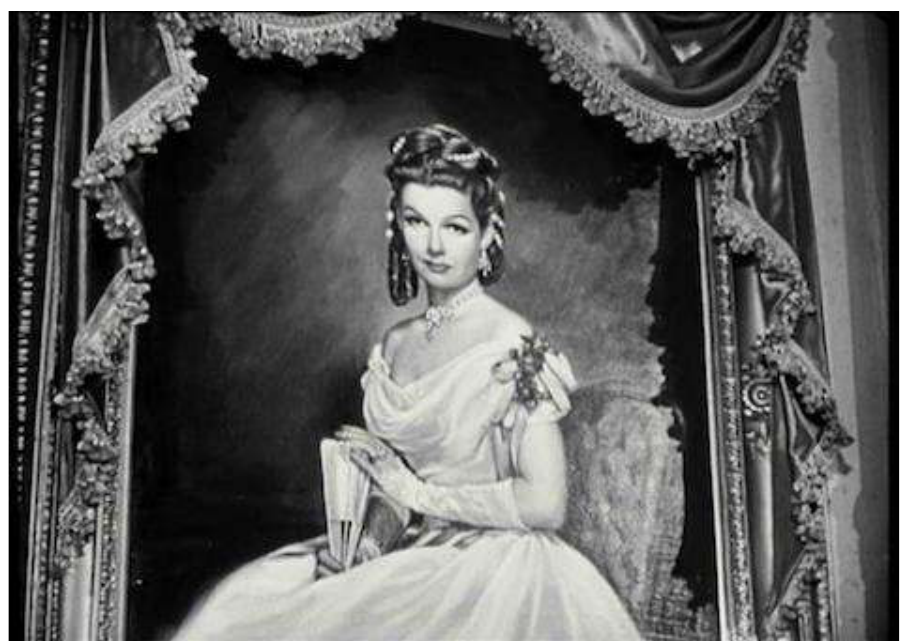
Figure 22: The portrait in Silver